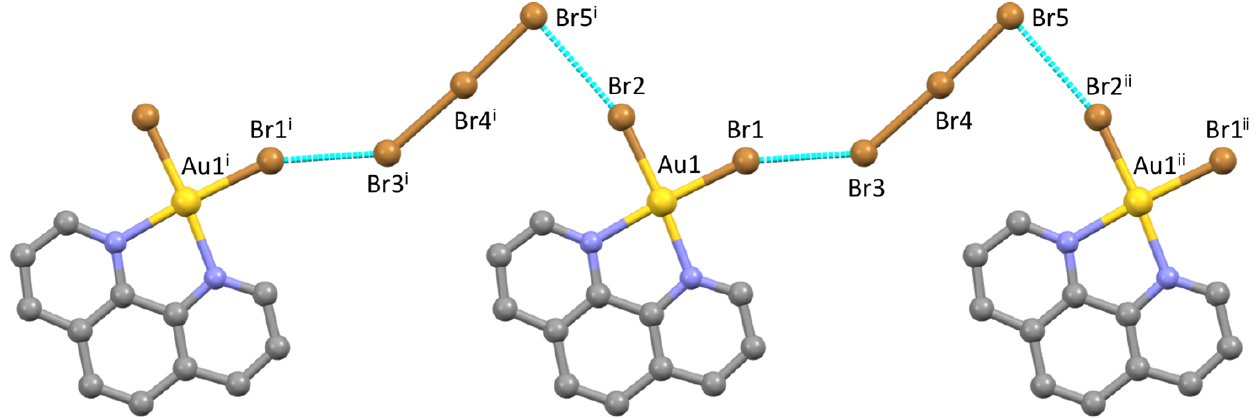
Figure 2. Au–Br···Br XB interactions resulting in a zig-zag infinite chain running along the c axis. i = x, y, − 1 + z; ii = x, y, 1 + z. Hydrogen atoms were omitted for clarity.